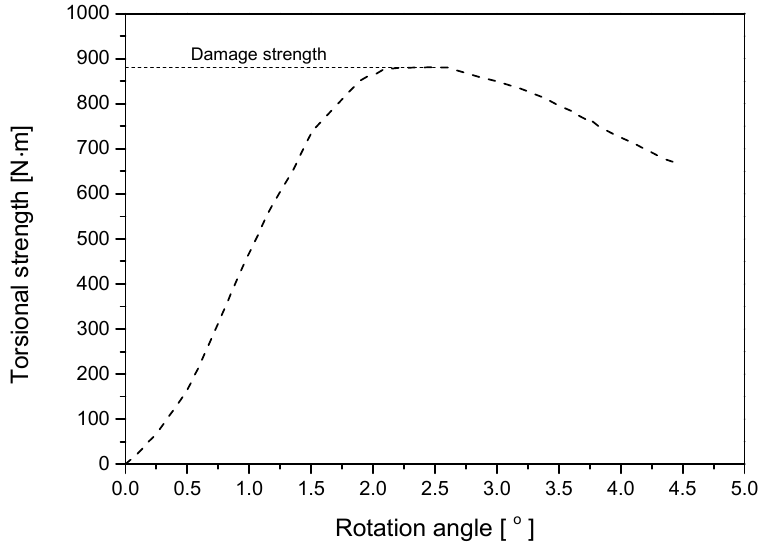
Figure 17. Torsional strength test result graph for WLF helical gear. Table 7. Performance results of the WLF helical gear.